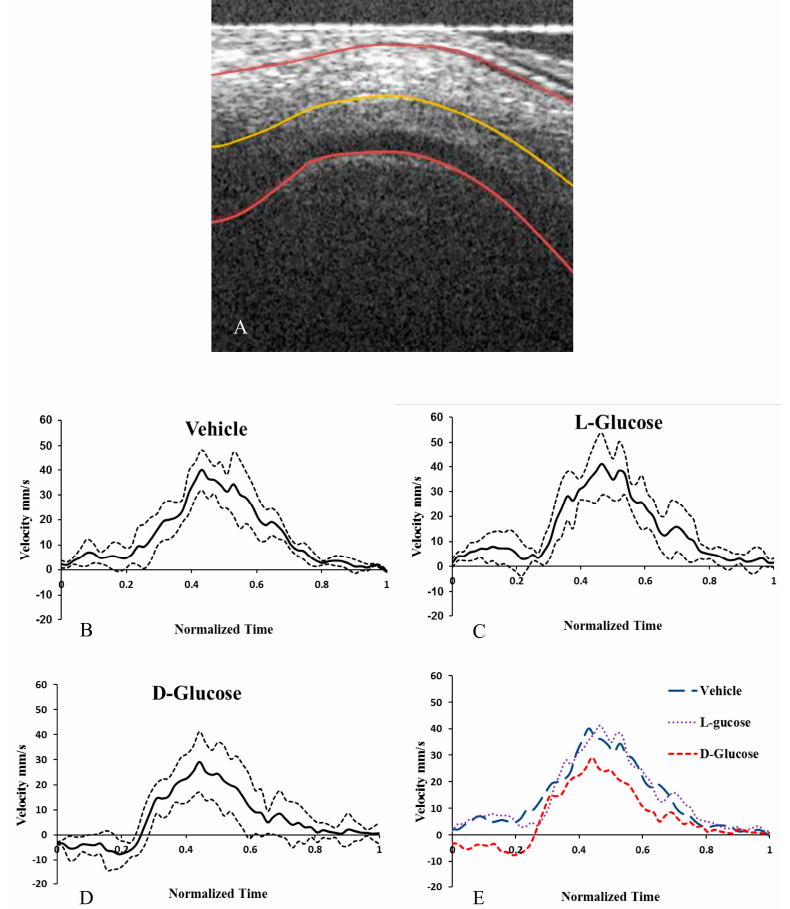
Figure 6. Hyperglycemia alters the hemodynamics in chick embryonic OFT. OCT image of the longitudinal cross section of a vehicle control HH18 OFT with lumen and myocardium labelled ( A ). The outer walls and centerline of the OFT identified with the custom MATLAB program. The calculated centerline velocity of the vehicle control ( B ), osmotic control ( C ), and D -glucose-treated embryos ( D ) from the Doppler OCT images. The average velocities ( E ) for the treatments. Scale bar = 70 µ m. * p < 0.05